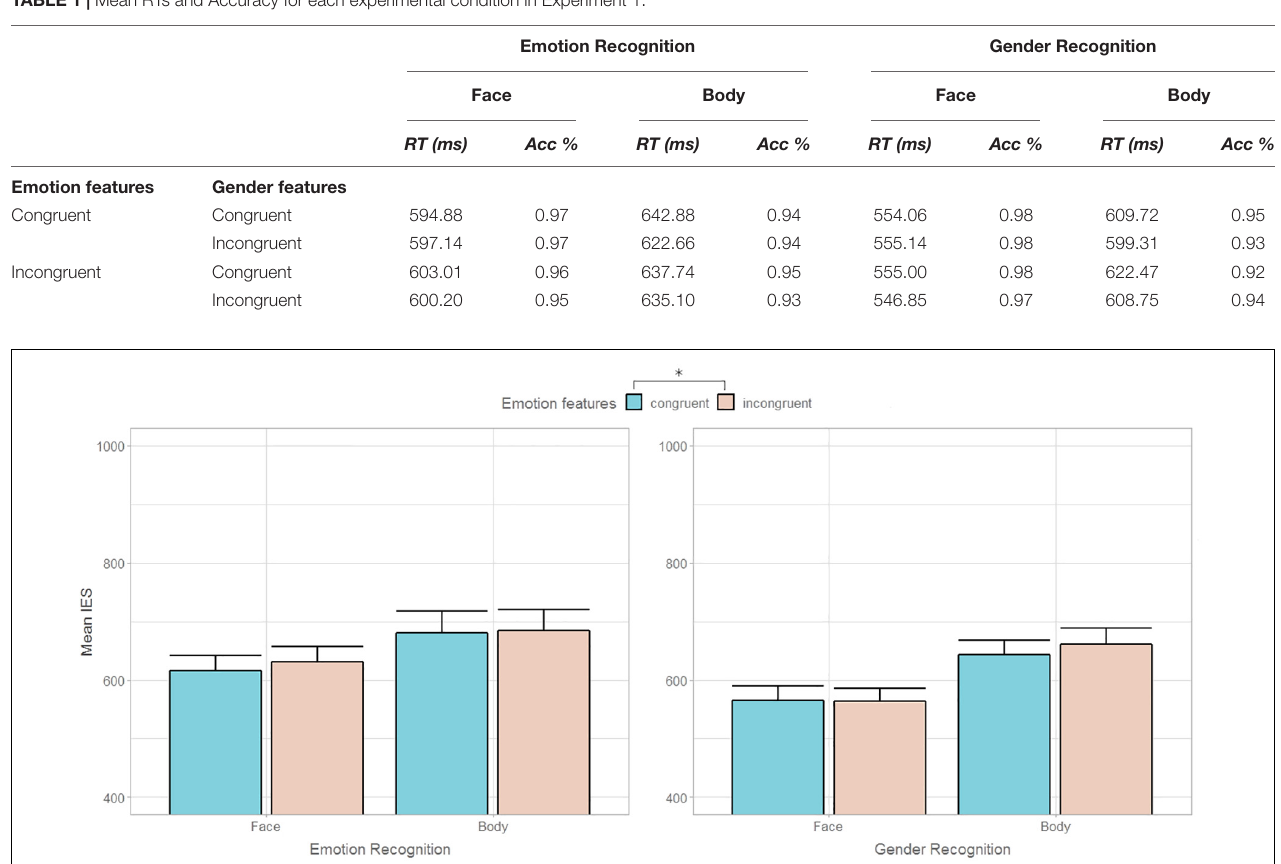
FIGURE 2 | Mean inverse efficiency scores (IES) during Emotion and Gender recognition according to task-relevant (left graph) and task-irrelevant (right graph) emotional congruency between target and flanker in Experiment 1. Error bars represent + 1 SEM. The asterisk ∗ indicates the main effect of emotion congruency ( p <